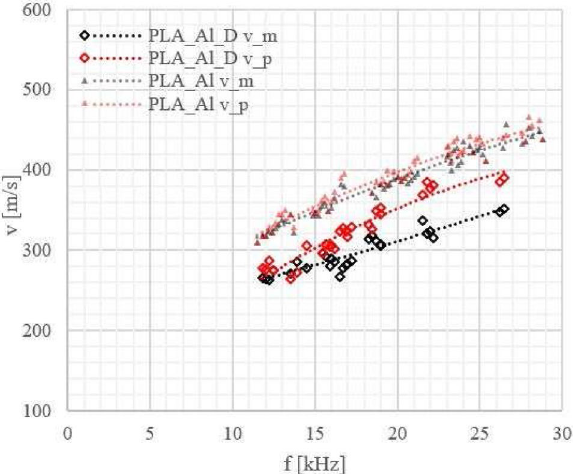
Figure 6. Lamb wave phase velocities for PLA_Al laminates without and with a defect:_D_; measurement errors: (cid:31) f = 1 Hz, (cid:31) v = 10 m/s. Velocities of the Lamb waves are marked: in black (v_m) for the metal part, in red (v_p) for the polymer part, △ for laminates without and ⋄ for laminates with a defect.